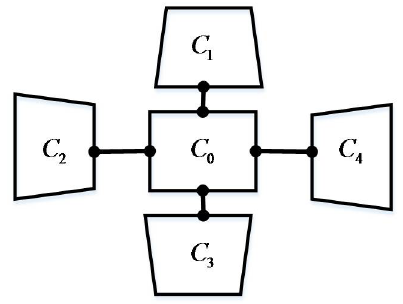
Figure 2. Five-lens oblique camera structure.